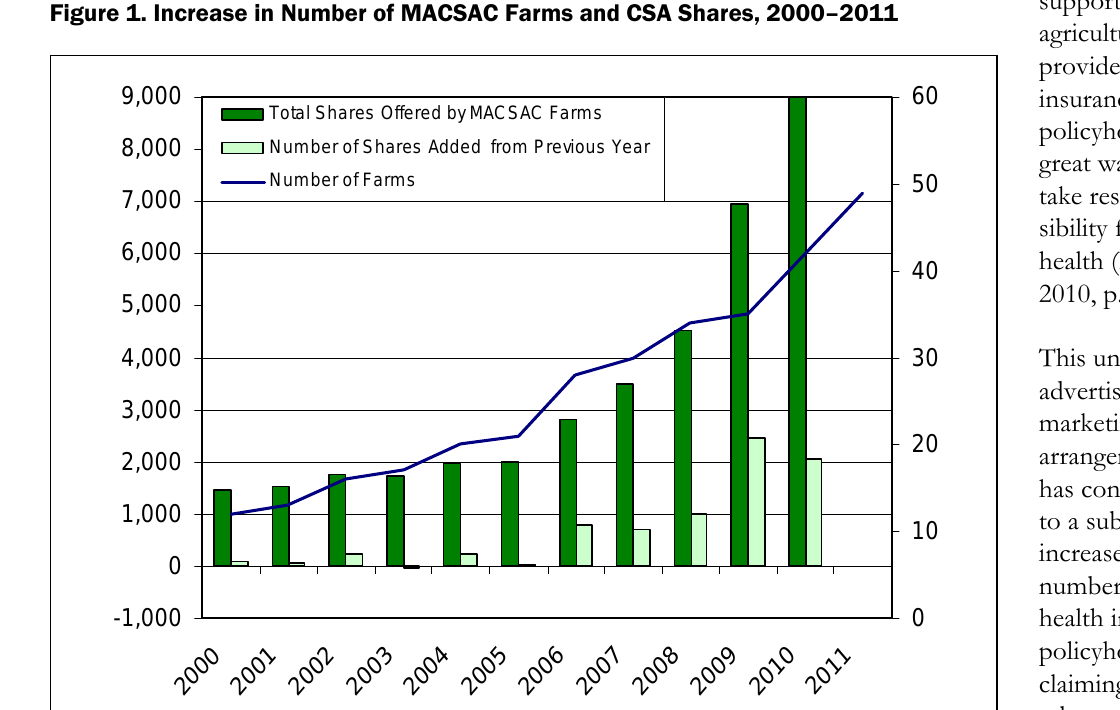
Figure 1. Increase in Number of MACSAC Farms and CSA Shares,